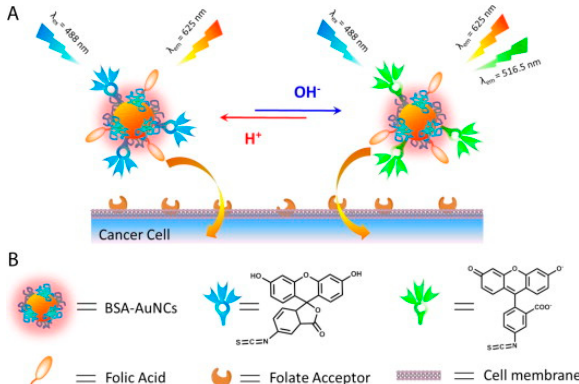
Figure 5. ( A ) Principle of folic acid and fluorescein functionalized AuNCs fluorescent biosensor for cancer cell-targeted imaging and pH detection, ( B ) Structure of AuNCs and decorated ligands. Reprinted with permission [56]. Copyright 2014, Elsevier B.V.